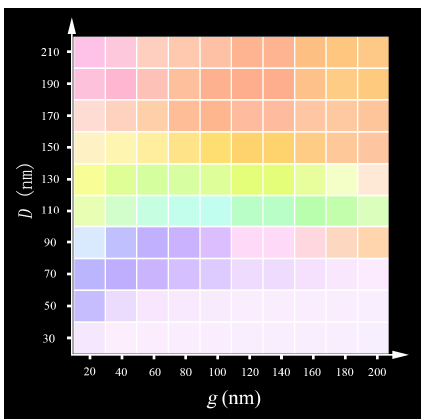
Figure 8. The colormap based on FDTD simulations. D varies from 30 nm to 210 nm, g varies from 20 nm to 200 nm.